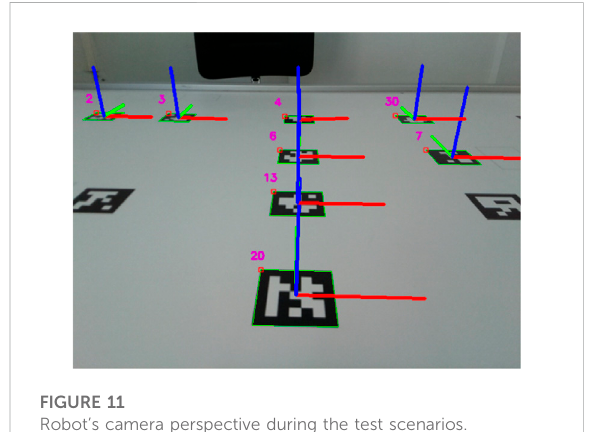
FIGURE 11 Robot ’ s camera perspective during the test